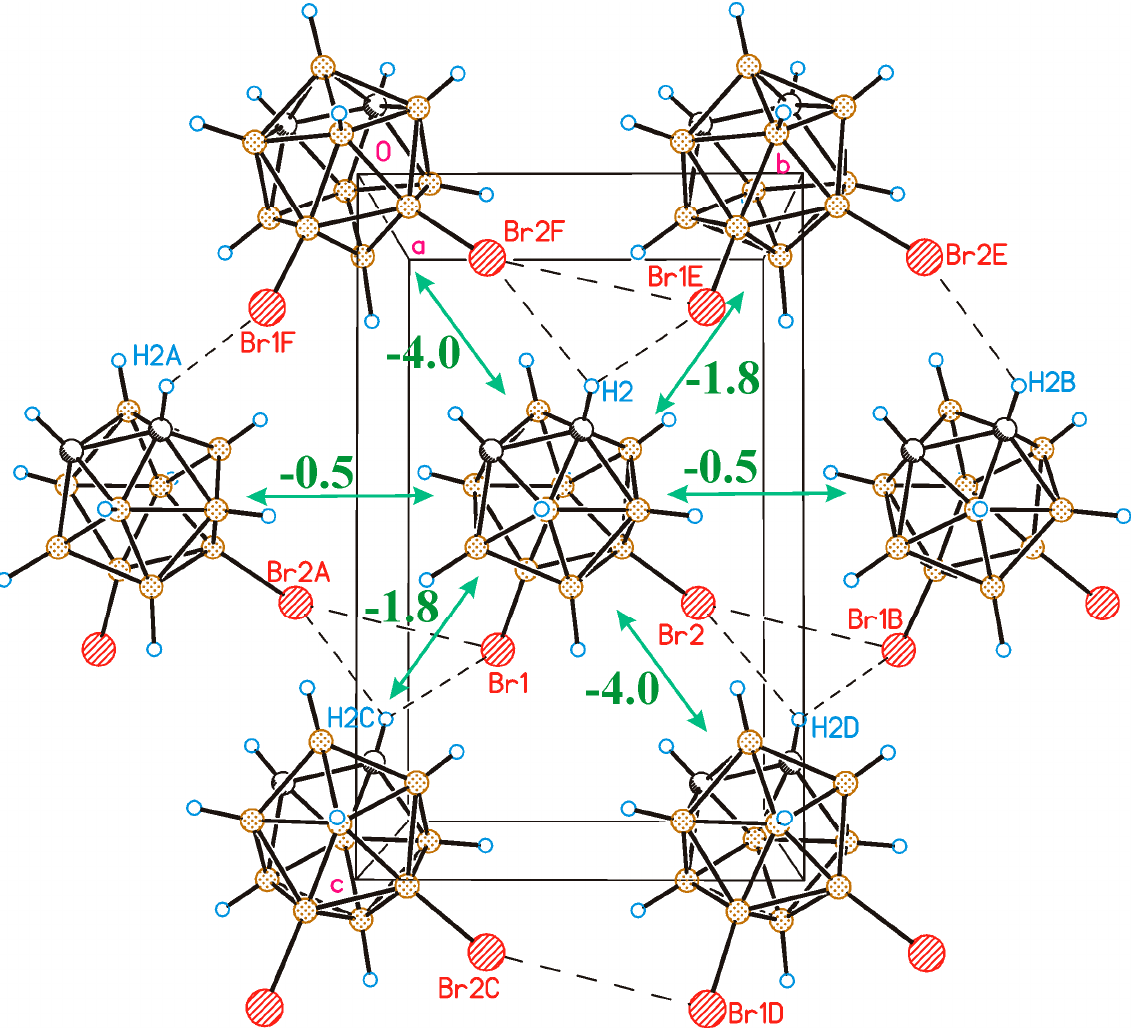
Figure 2. Crystal packing fragment of 9,12-Br 2 - ortho -C 2 B 10 H 10 . Numbers at the green arrows correspond to pair interaction energies.